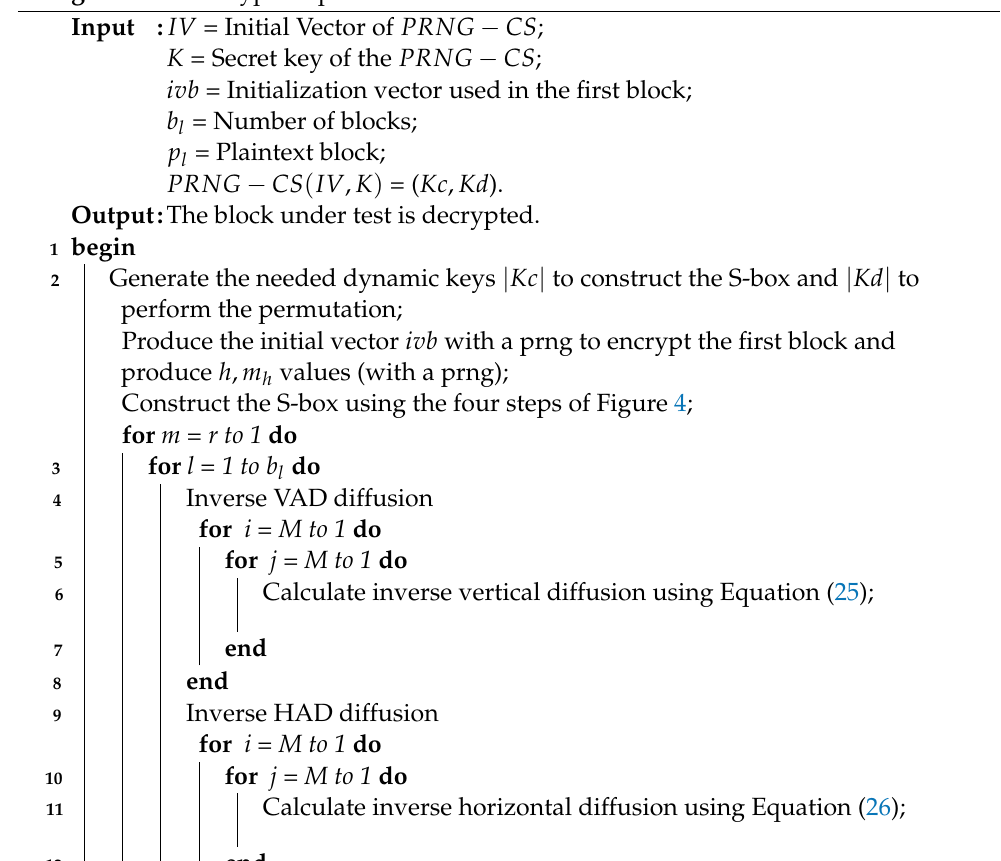
Algorithm 2 Decryption